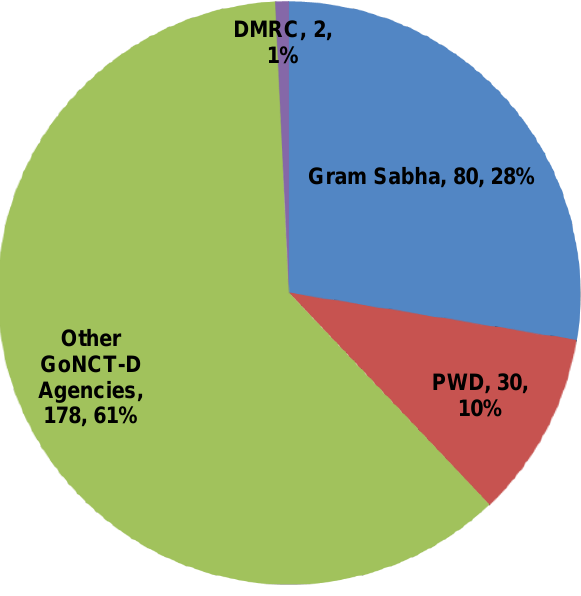
Figure 10: Landowning agencies of 290 sites handed to